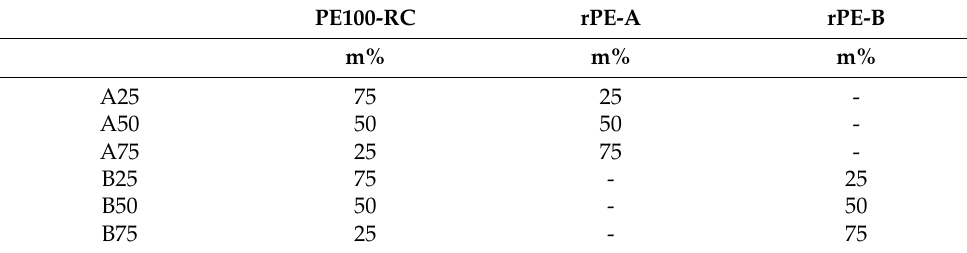
Table 1. List of compounds and their respective amounts of blending